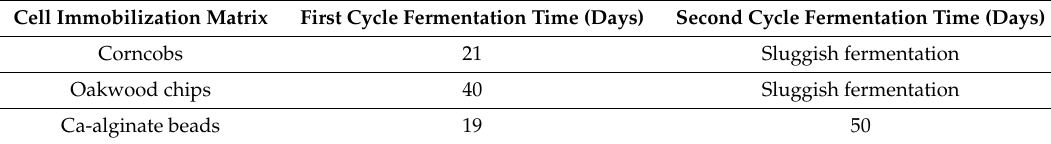
Table 3. Fermentation period for both cycles of